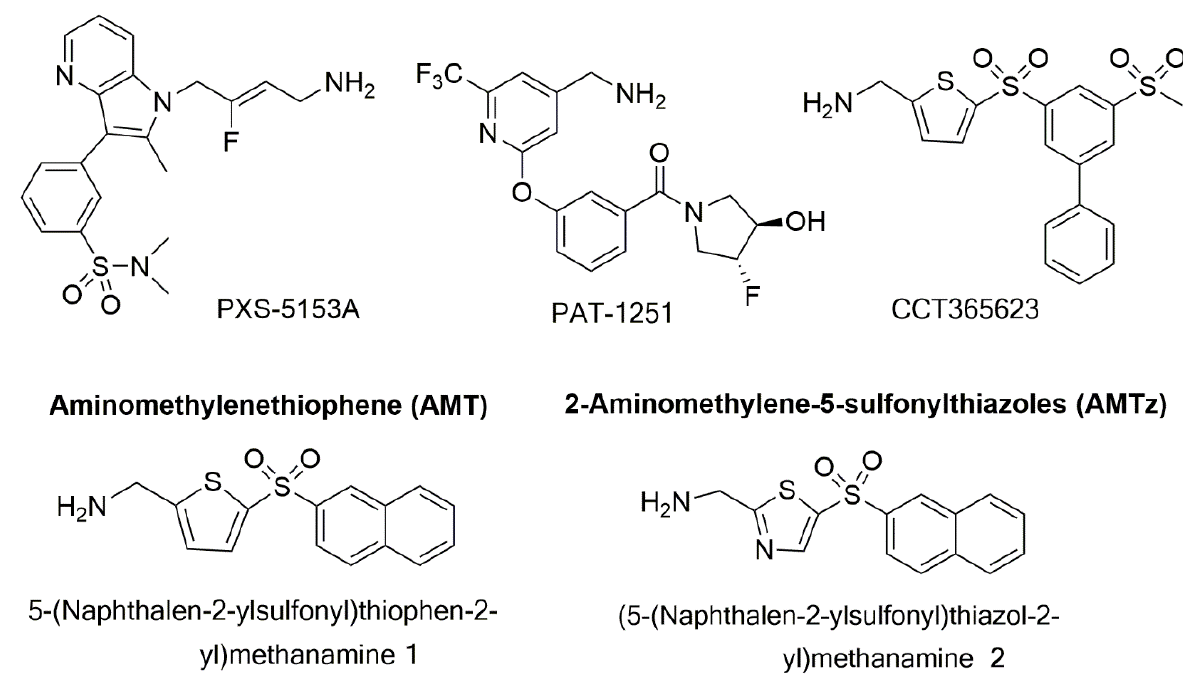
Figure 5. Structures of PXS-5153A; PAT-1251; CCT365623; an aminomethylenethiophene (AMT), 5-(naphthalen-2-ylsulfonyl)thiophen-2-yl)methamine 1; and a 2-aminomethylene-5-sulponylthiazole (AMTz), (5-(naphthalen-2-ylsulfonyl)thiazol-2-yl)methanamine 2.